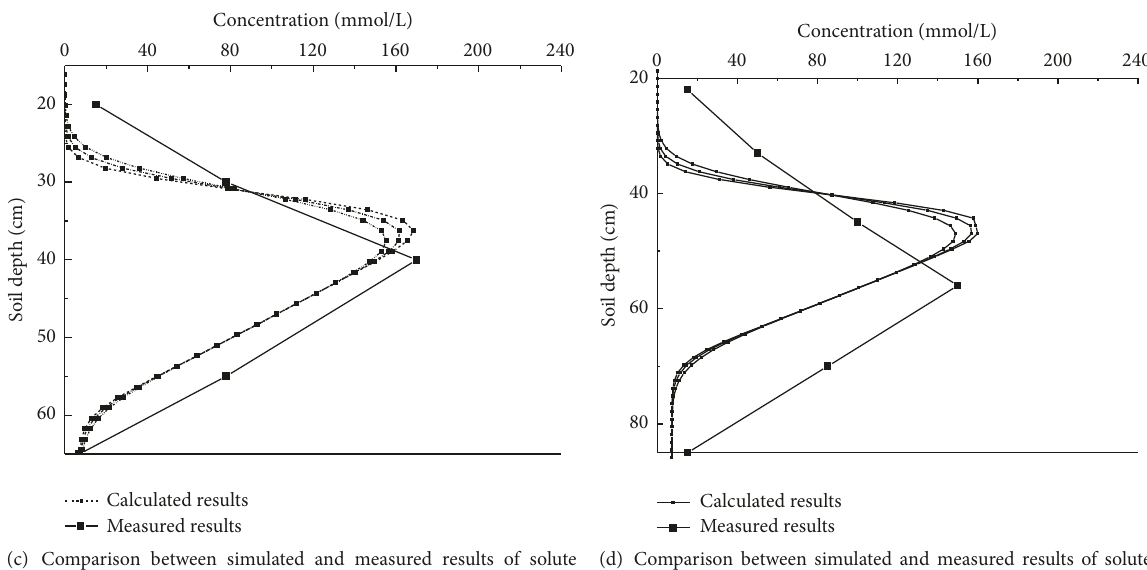
Figure 1: The comparison between numerically simulated and measured results of distributions of water content and concentration in the